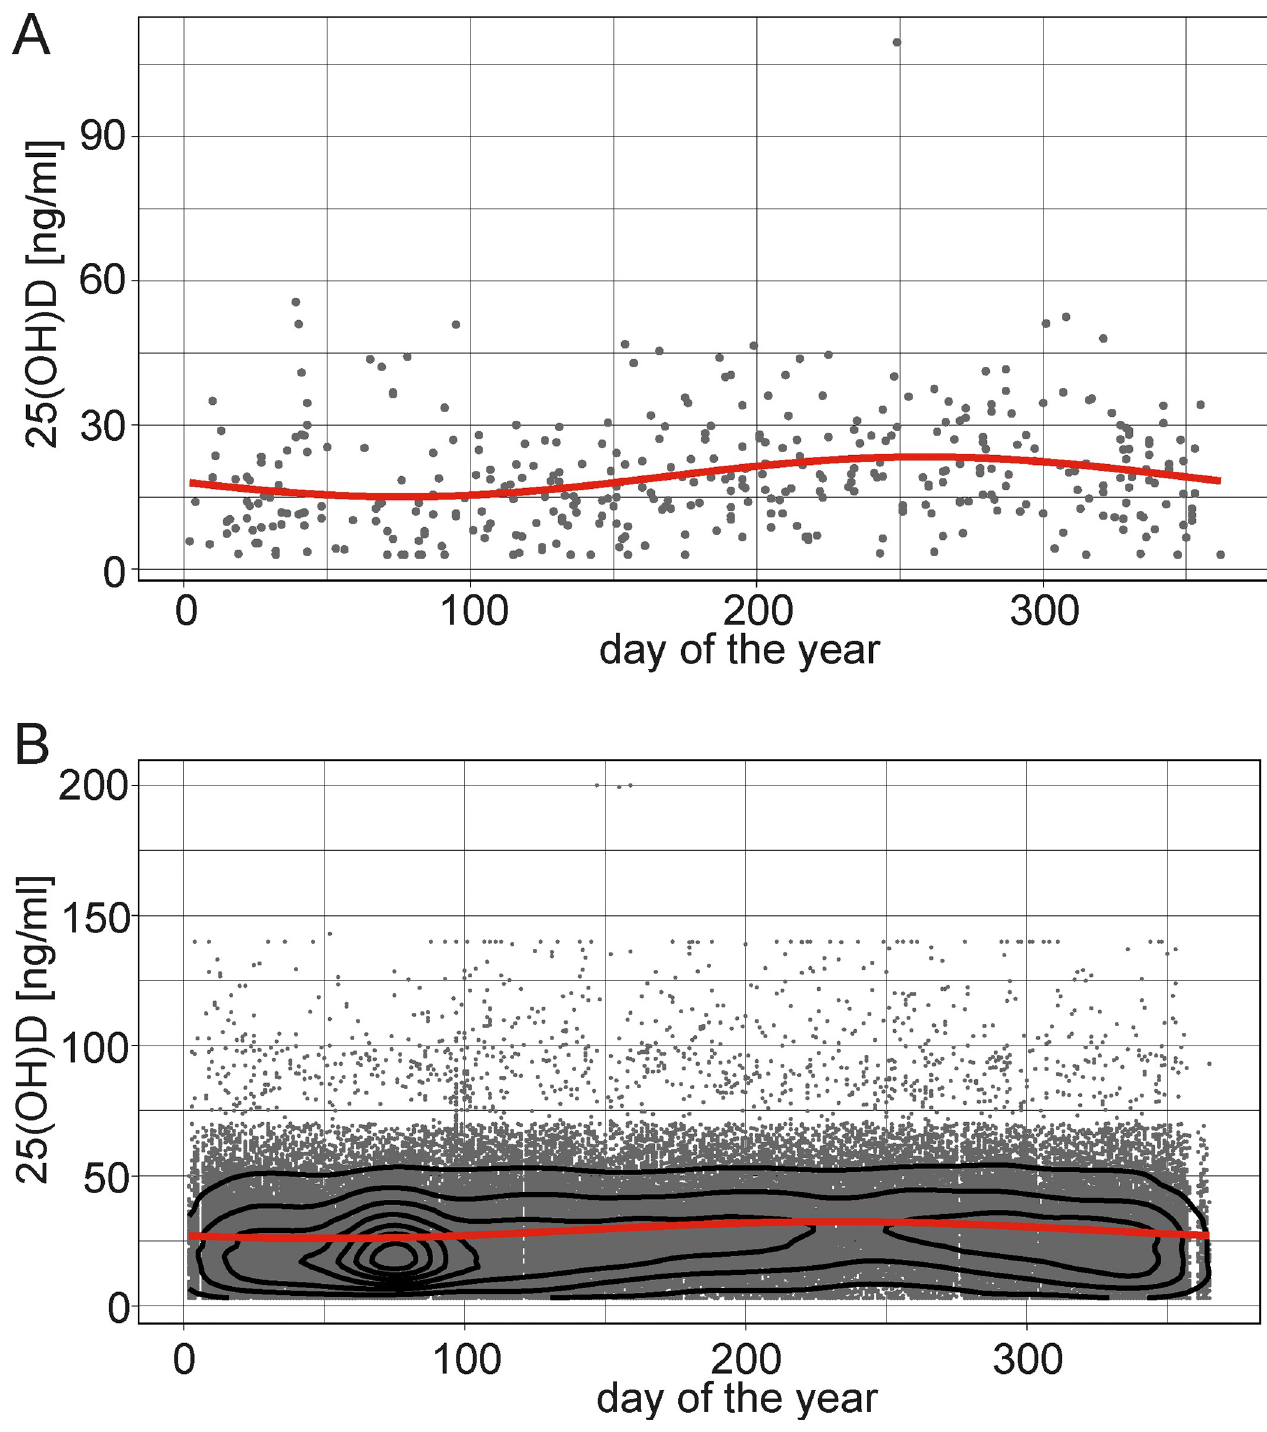
Fig 1. Sinusoidal pattern of 25(OH)D serum concentrations. (A) 25(OH)D serum concentrations measured in IBD patients at baseline and day of the year of the respective analysis are plotted. Sinusoidal regression analysis was performed to model a curve of the predicted 25(OH)D concentration over the year. (B) 25 (OH)D serum concentrations measured in controls and day of the year of the respective analysis are plotted. Sinusoidal regression analysis was performed to model a curve of the predicted 25(OH)D concentration over the year. This fitted sinus curve had the equation y = 29.13+3.224 � sin( x +0.861); F-statistic: 854.3 on 2 and 86548 DF, p-value: < 2.2e-16; MSE: 263.846.